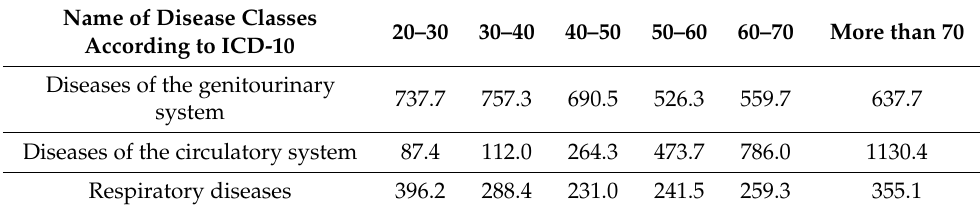
Table 4. Prevalence of prevailing classes of diseases by age categories of the Bidaykol